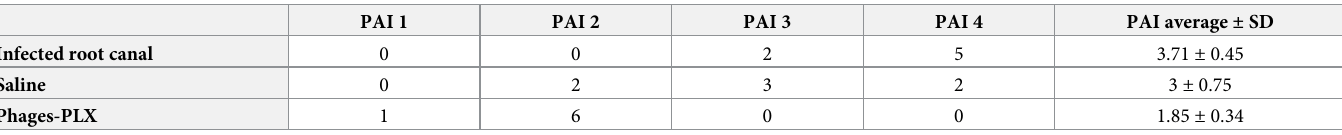
Table 1. Histological analysis of the antibacterial activity on host inflammation in the periapical area—Periapical Index (PAI � ) (n = 7 each group). PAI 1 PAI